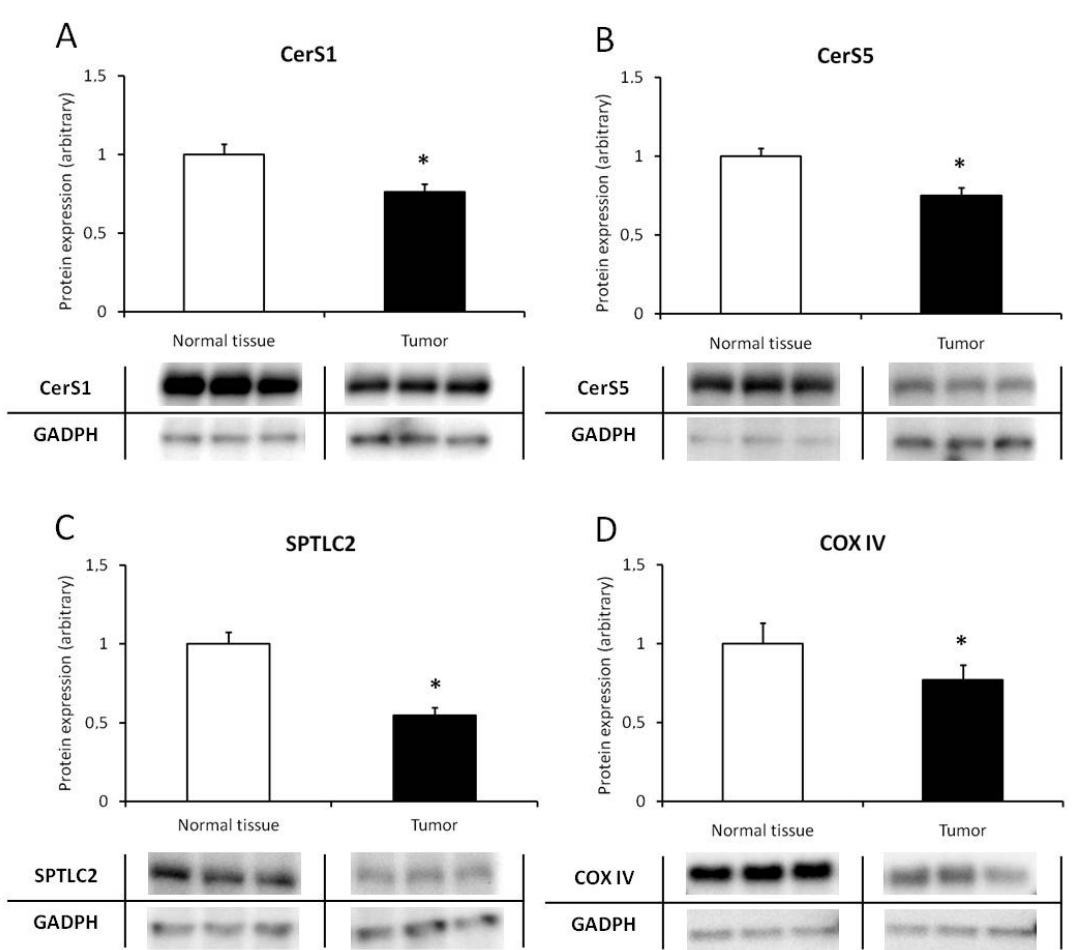
Figure 1. Protein expression of de novo ceramide synthesis enzymes ( A – C ) and mitochondrial marker ( D ) in normal colorectal tissue and colorectal cancer tissue. The values represent the mean protein expression +/ ‐ SEM, normalized to glyceraldehyde 3 ‐ phosphate dehydrogenase (GADPH) housekeeping protein expression; * p < 0.05 vs. tumor tissue ( n = 11), as estimated by paired t ‐ test. ( A ) CerS1–ceramide synthase 1; ( B ) CerS5–ceramide synthase 5; ( C ) SPTLC2–serine palmitoyltransferase catalytical subunit 2; ( D ) COX IV–cytochrome C oxidase, subunit IV; GADPH–glyceraldehyde ‐ 3 ‐ phosphate dehydrogenase. Pictures below graphs show representative blots from sample pools and were not used for calculation.